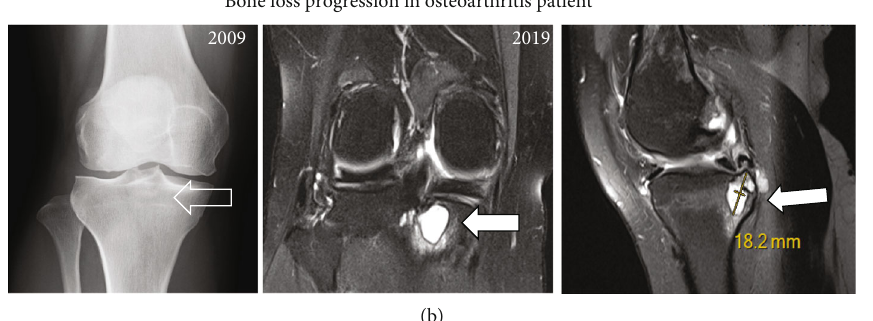
Figure 1: Clinical changes seen in RA and OA patient knees. Panel (a) shows the progression of erosive arthritis due to RA in a knee of female patient during 2017 to 2021 and intraoperative picture during a knee prosthesis operation demonstrates synovial in fl ammation and hypertrophy (a) along with cartilage (b) and bone damage (c) associated with synovial hypervascularity and oedema. The medial tibial plateau (arrows) is heavily eroded during the follow-up time period. Panel (b) shows X-ray and MRI images of a young female ’ s knees. At the age of 27, only some early OA changes are seen. The magnetic resonance images ten years later show progression of OA, with large subchondral bone loss and a cyst in the proximal tibia as an indication of increased bone